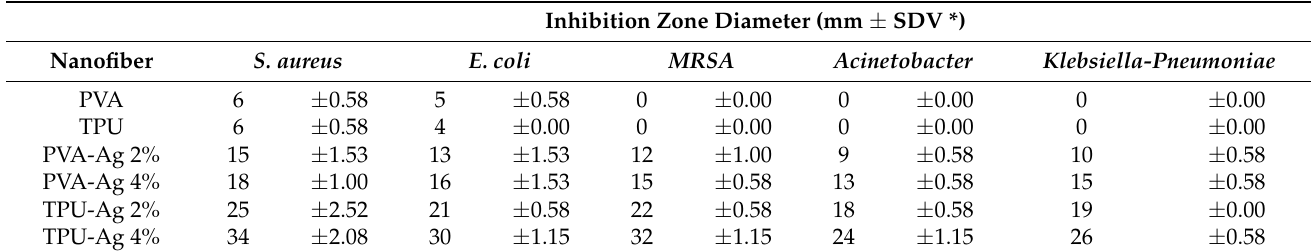
Figure 6. Relationship between average inhibition zone and Ag NPs loading concentration on PVA and TPU nanofibers. Table 2. The average inhibition zone with the Ag loading concentration on PVA and TPU nanofibers.